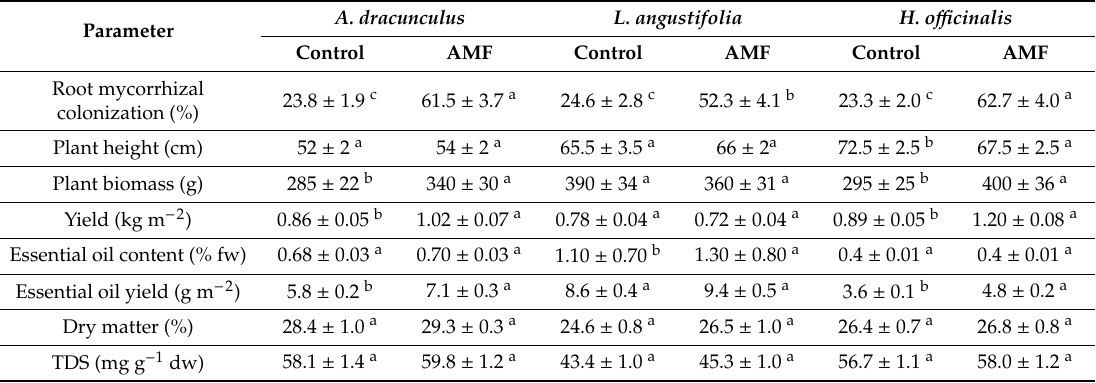
Table 1. E ff ect of AMF on plant growth and root mycorrhizal colonization, yield, essential oil content and TDS of aromatic